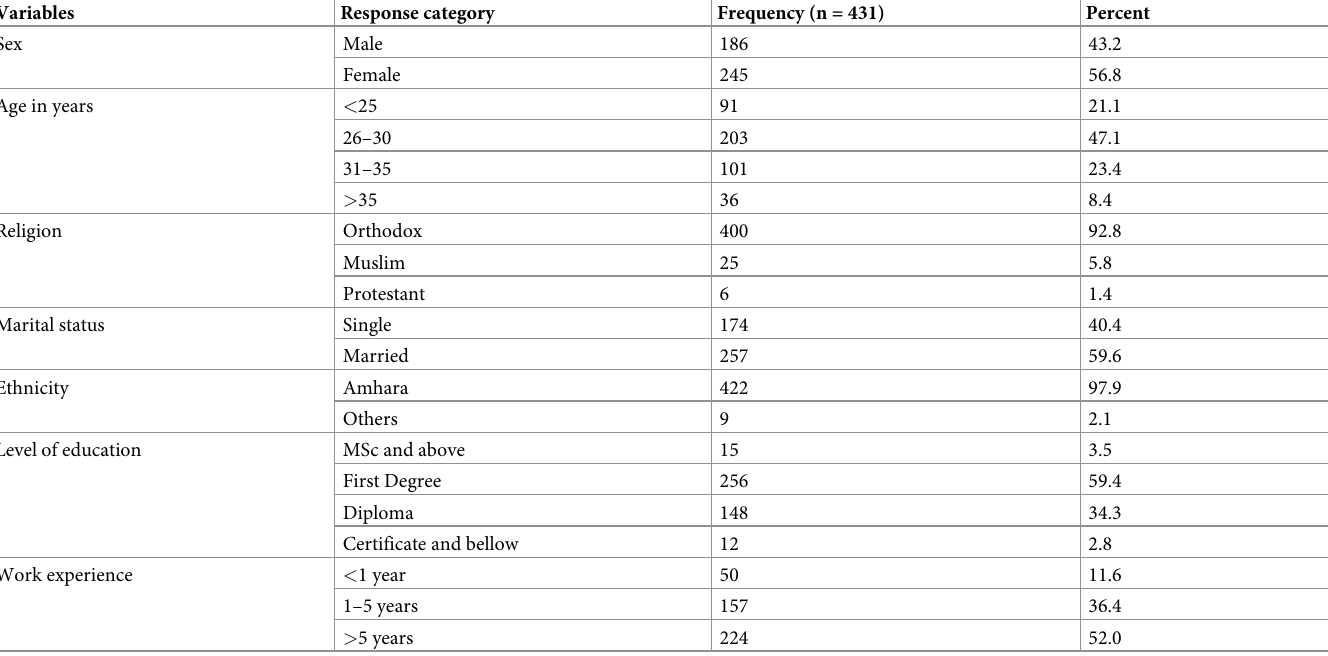
Table 1. Socio-demographic variables for BMWM among HCWs at metropolitan cities private hospitals of Amhara region, Ethiopia, December 2020.